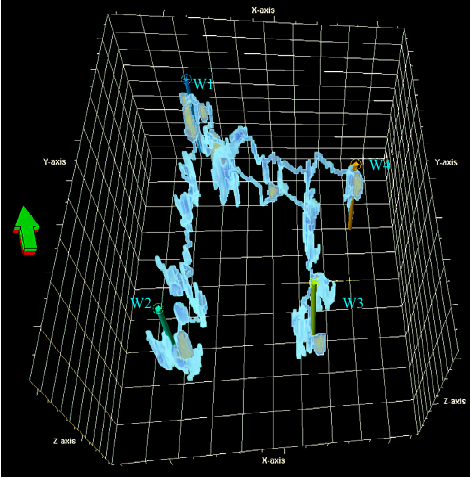
Figure 5. The schematic diagram of the optimal path of A well group. Table 2. The results of static well connected mode of A well group based on the ratio of caves.